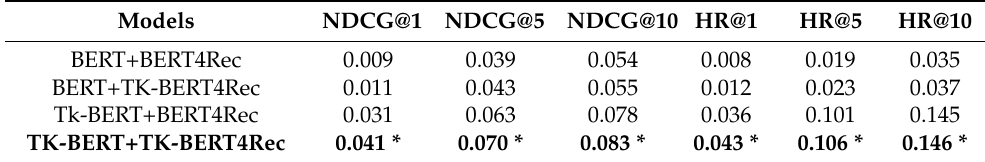
Table 4. Experimental results of ablation experiments using the CwConvRec dataset. Models Table 5. Experimental results of ablation experiments using the KdConvRec